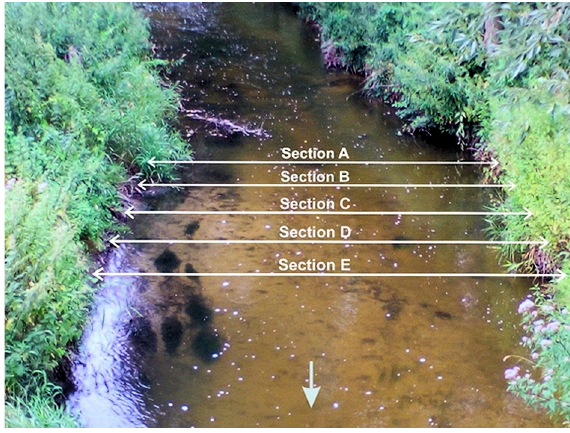
Fig. 7. hypsometric profile of the area in the bottom part of the Moszczenica valley between Wypychów and Gieczno (Fig. 1C). Based on the digital elevation model of the Geoportal of the Łódzkie Voivodship.